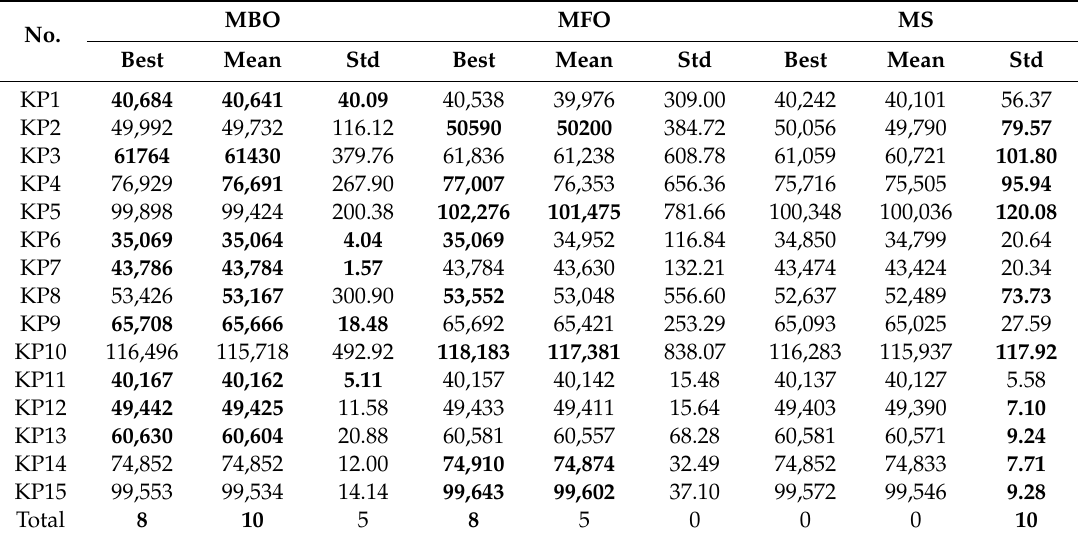
Table 15. Performance comparison of three algorithms on large-scale 0-1 KP